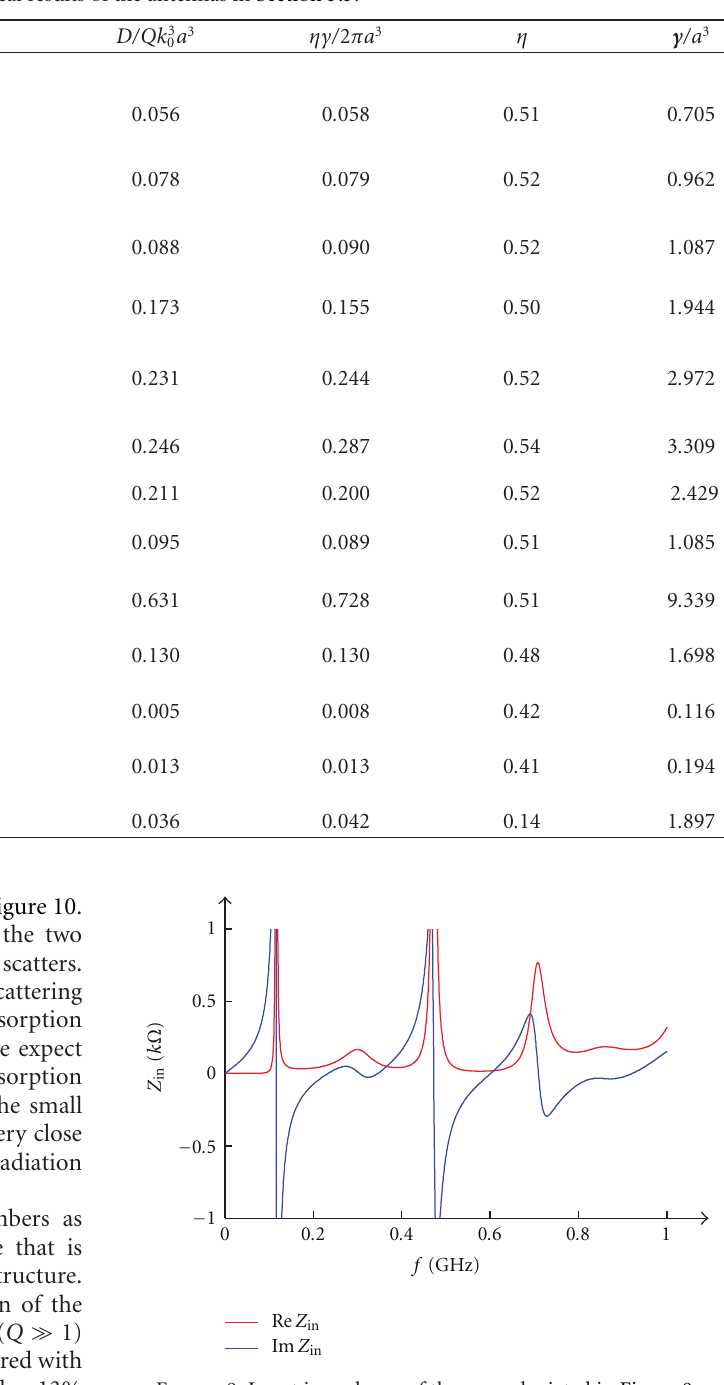
first eight rows in the table correspond to planar geometries circumscribed by di ff erent l 1 × l 2 rectangles with l 1 /l 2 , respectively, equal to: 500, 100, 25, 9, 3 . 6, 2, 1, and 0 . 5. The polarization is always directed along l 1 . There are two meander-type antennas which di ff er by their aspect ratios and feeding structure. The ninth and tenth rows